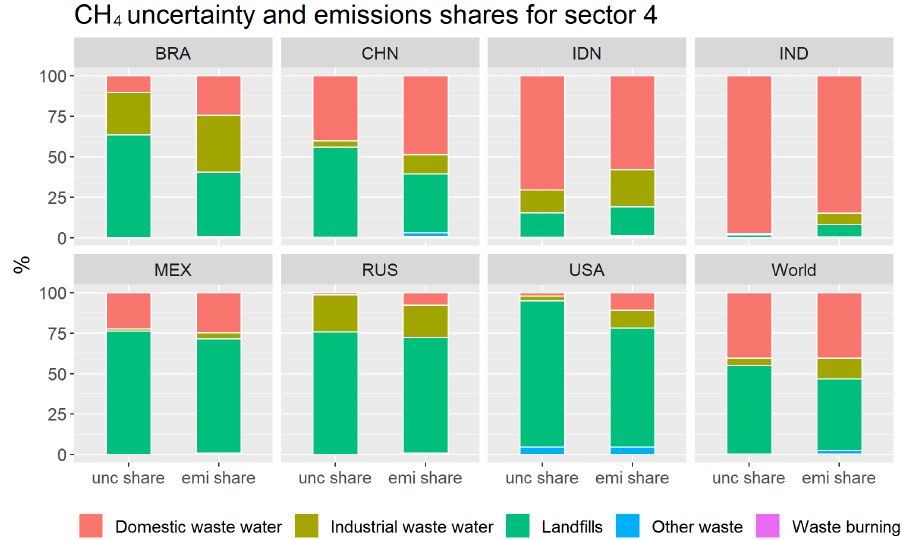
Figure 10. CH 4 uncertainty and emissions shares for EDGAR’s emission sectors under IPCC category 4 for Brazil, China, Indonesia, India, Mexico, Russia, the USA, and the